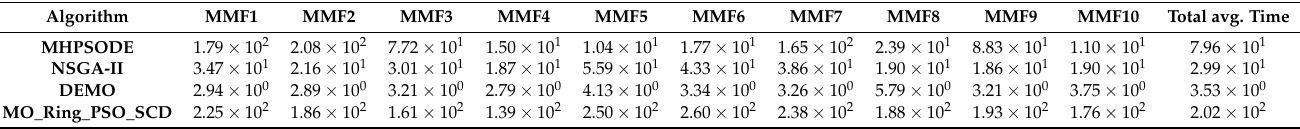
Table 6. Average computation times of the considered algorithms on CEC2009 benchmark functions.